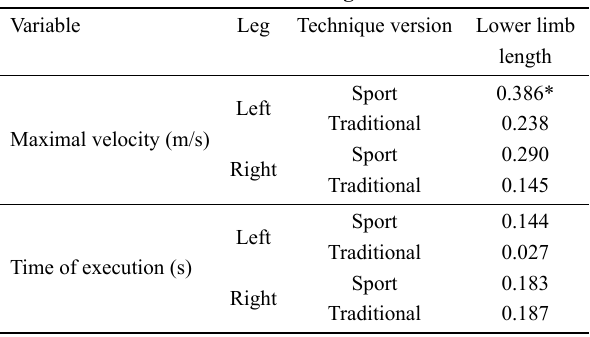
Table 5. Correlation table between kinematic indicators and lower limb